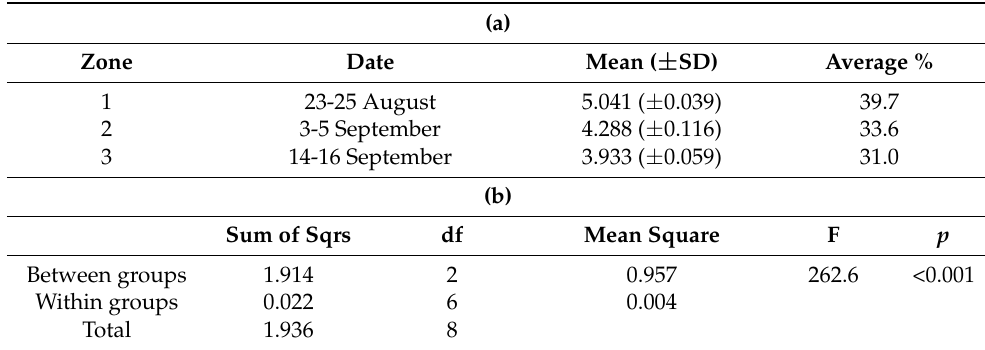
Table 1. (a) Mean ( ± SD) weight losses (g) of calcium sulfate balls after 72 hours and respective average percentage as measure of water movement at the three zones investigated. (b) Results of analysis of variance (ANOVA) on the weight losses of calcium sulfate balls as measure of water movement at the three investigated zones of the cave.